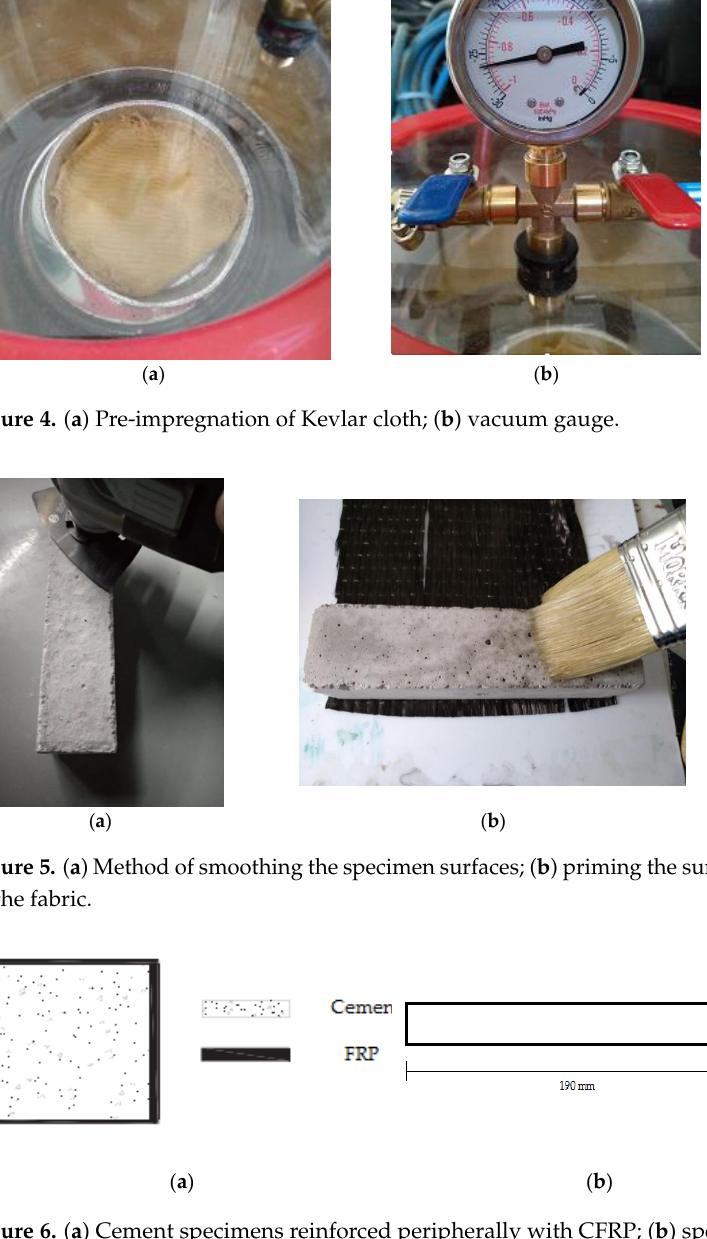
Figure 6. ( a ) Cement specimens reinforced peripherally with CFRP; ( b ) specimens’ dimensions for the bending and shear strength measurement. The composites were manufactured with epoxy resin with unidimensional and two- dimensional (twill) fabrics to measure their shear and bending strength. All composites were made using the hand lay-up method [7]. Figure 6b illustrates the dimensions of the samples for the measurement of shear and bending strength. The calculation of the layers of fabrics for the manufacture of the composite materials was in accordance with the thickness of the fabrics. The thickness for the unidimensional carbon fabric was 0.630 mm and for the two-dimensional (twill) fabrics, the thicknesses were 0.285 mm for carbon, 0.300 mm for glass, and 0.400 mm for Kevlar. Hence, to man- ufacture composite materials with 3 mm thickness, the unidimensional carbon fabric re- quired five layers weighing 358 g. In terms of the two-dimensional (twill) fabrics, for car- bon, eleven layers were required weighing 405 g; for glass, ten layers were needed weigh- ing 324 g; and for Kevlar, eight layers weighing 506 g were required (according to ASTM D-7617). Additionally, to manufacture the composite materials, the fabric/resin ratio was 50% w / w . The volume ratio of fabric/resin was 53% v/v . For the reinforced cement speci- mens with the retrofitting method, the fabric volume ratio was 3% v/v (for two layers of fabric). For the cement specimens reinforced with chopped carbon fibers, the fiber/cement ratio was 0.1% w/w . The specimens made in the present study are depicted in Figures 7– 9, while the specimens suitable for the bending and shear strength measurements are shown in Figure 10.